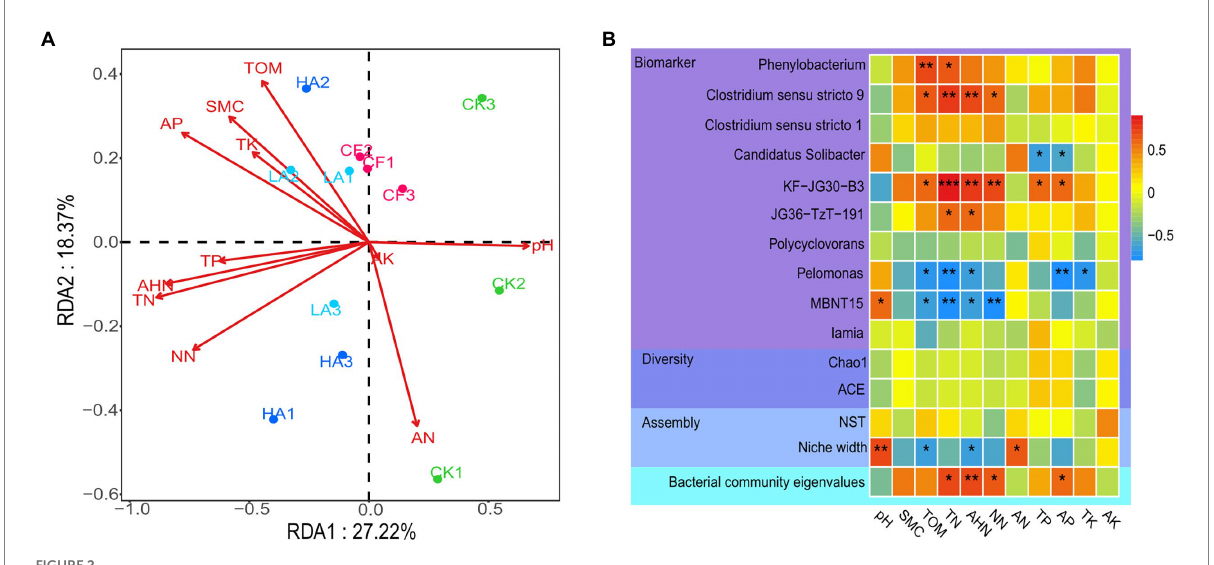
FIGURE 2 Relationships between the soil bacterial community and environmental factors. (A) Redundancy analysis between soil microorganisms and environmental factors. (B) Spearman correlation heatmaps of environmental factors and bacterial diversity, dominant genera, and bacterial community assembly. Red represents a positive correlation, and blue represents a negative